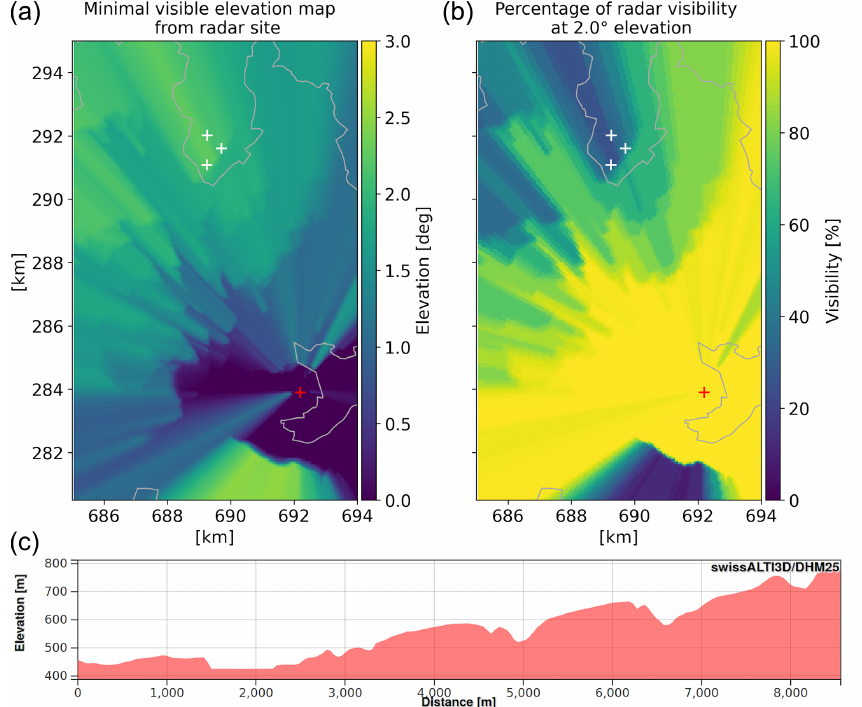
Figure 1. Visibility contour maps from DEM-based GECSX (Ground Echo Clutter Simulator) simulations for the radar observation site close to Schaffhausen. Minimal-visibility map (elevation for maximum of 50% beam blockage) is shown in plot (a) . Plot (b) shows the derived percentages of visibility for the fixed antenna elevation of 2 . 0 ◦ . White plus signs indicate the wind turbine locations and the red plus signs the weather radar location. Additionally the cross-section of the terrain profile between the radar observation site (left end of cross-section) and the wind turbine of the wind park with the largest distance to the radar (right end of cross-section) is presented in (c) . The last plot was produced on the swisstopo website (https://www.geo.admin.ch/, last access: 21 March